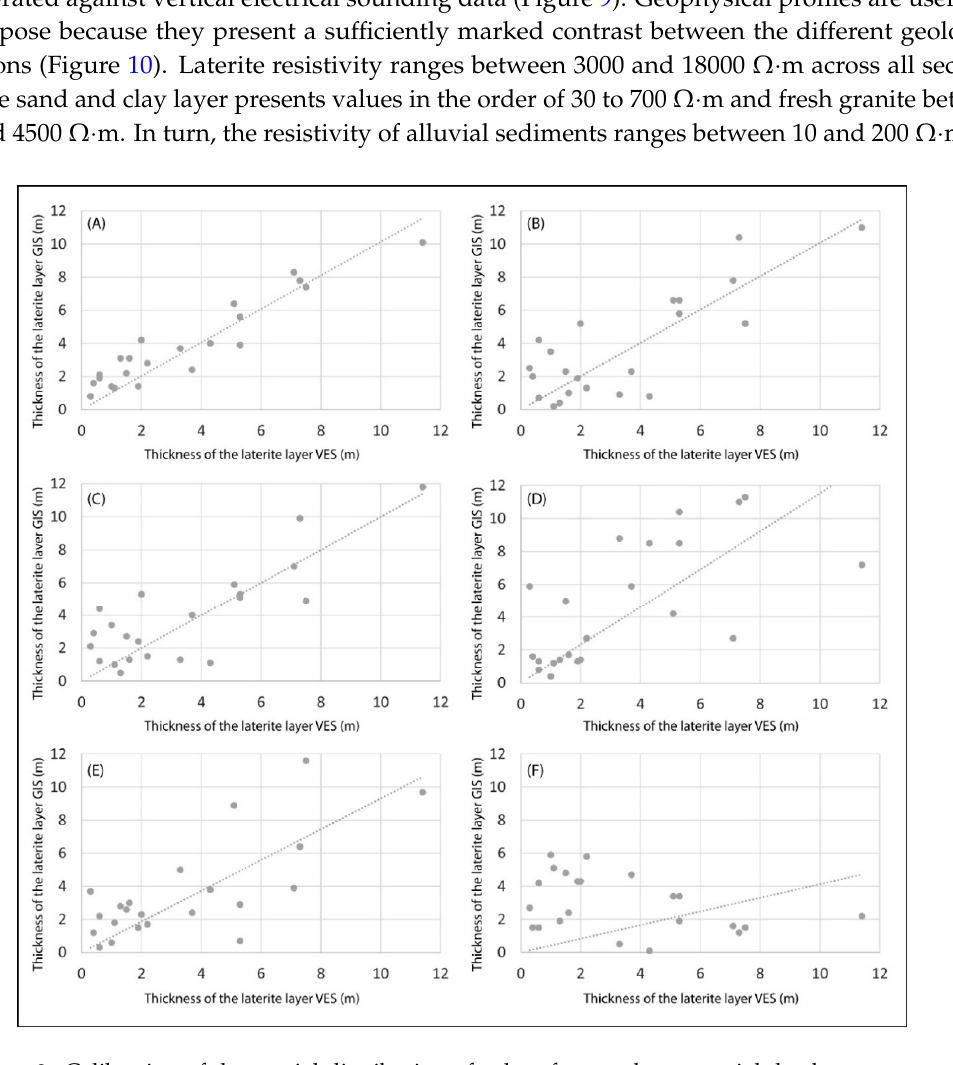
Table 4. Univariate cross-validation statistics for spatially interpolated data (water table level). Variable Method Water table level (m a.s.l) Kriging